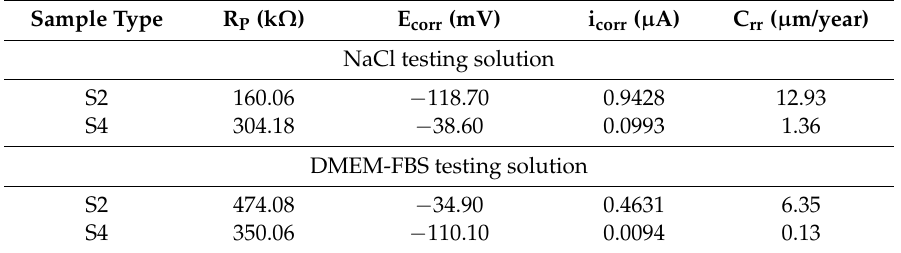
Table 5. Polarization resistance (R p ), corrosion potential (E corr ), corrosion current density (i corr ) and corrosion rates (C rr ) recorded for S2 and S4-type AlN films in NaCl saline solution and DMEM-FBS biomimetic